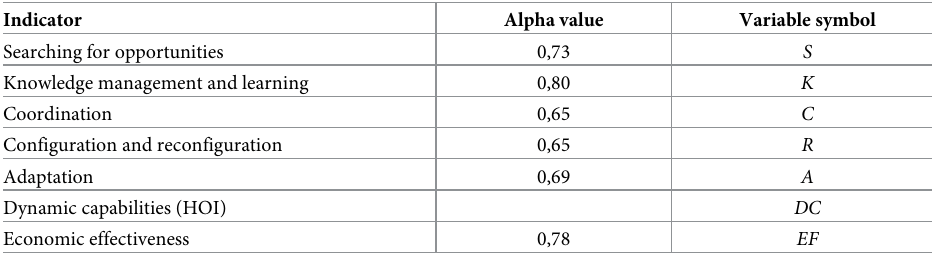
Table 3. Values of the Alfa Cronbach test reliability coefficient for individual